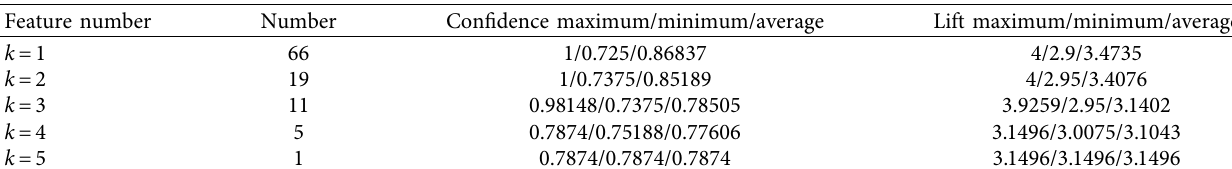
Figure 19: Average support of different feature state coding methods. Table 8: Fault diagnosis rules extraction results based on the equal-density discretization coding